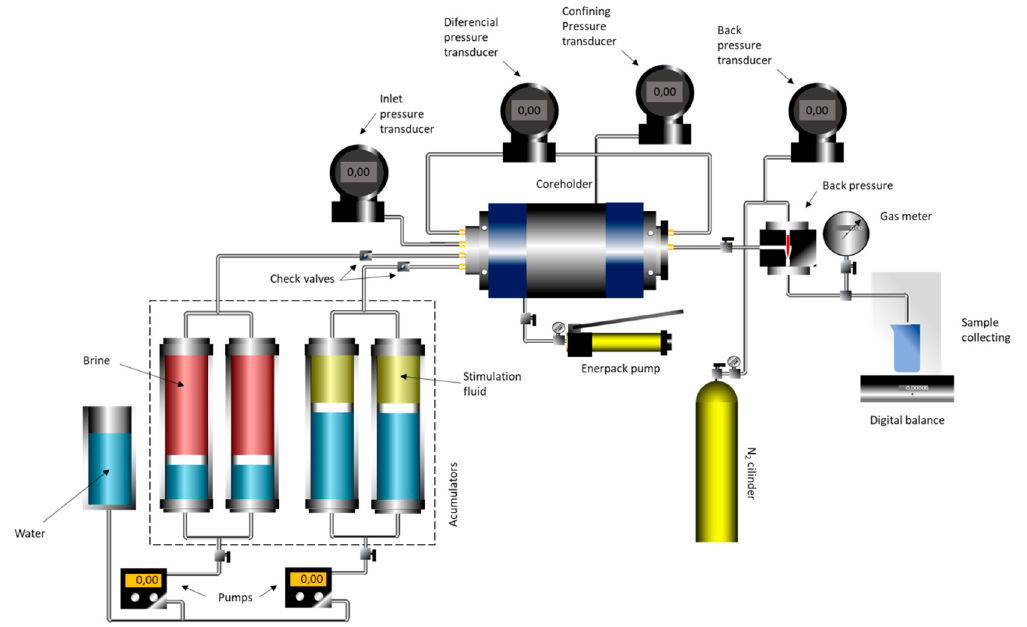
Figure 19. Schematic of coreflood setup.